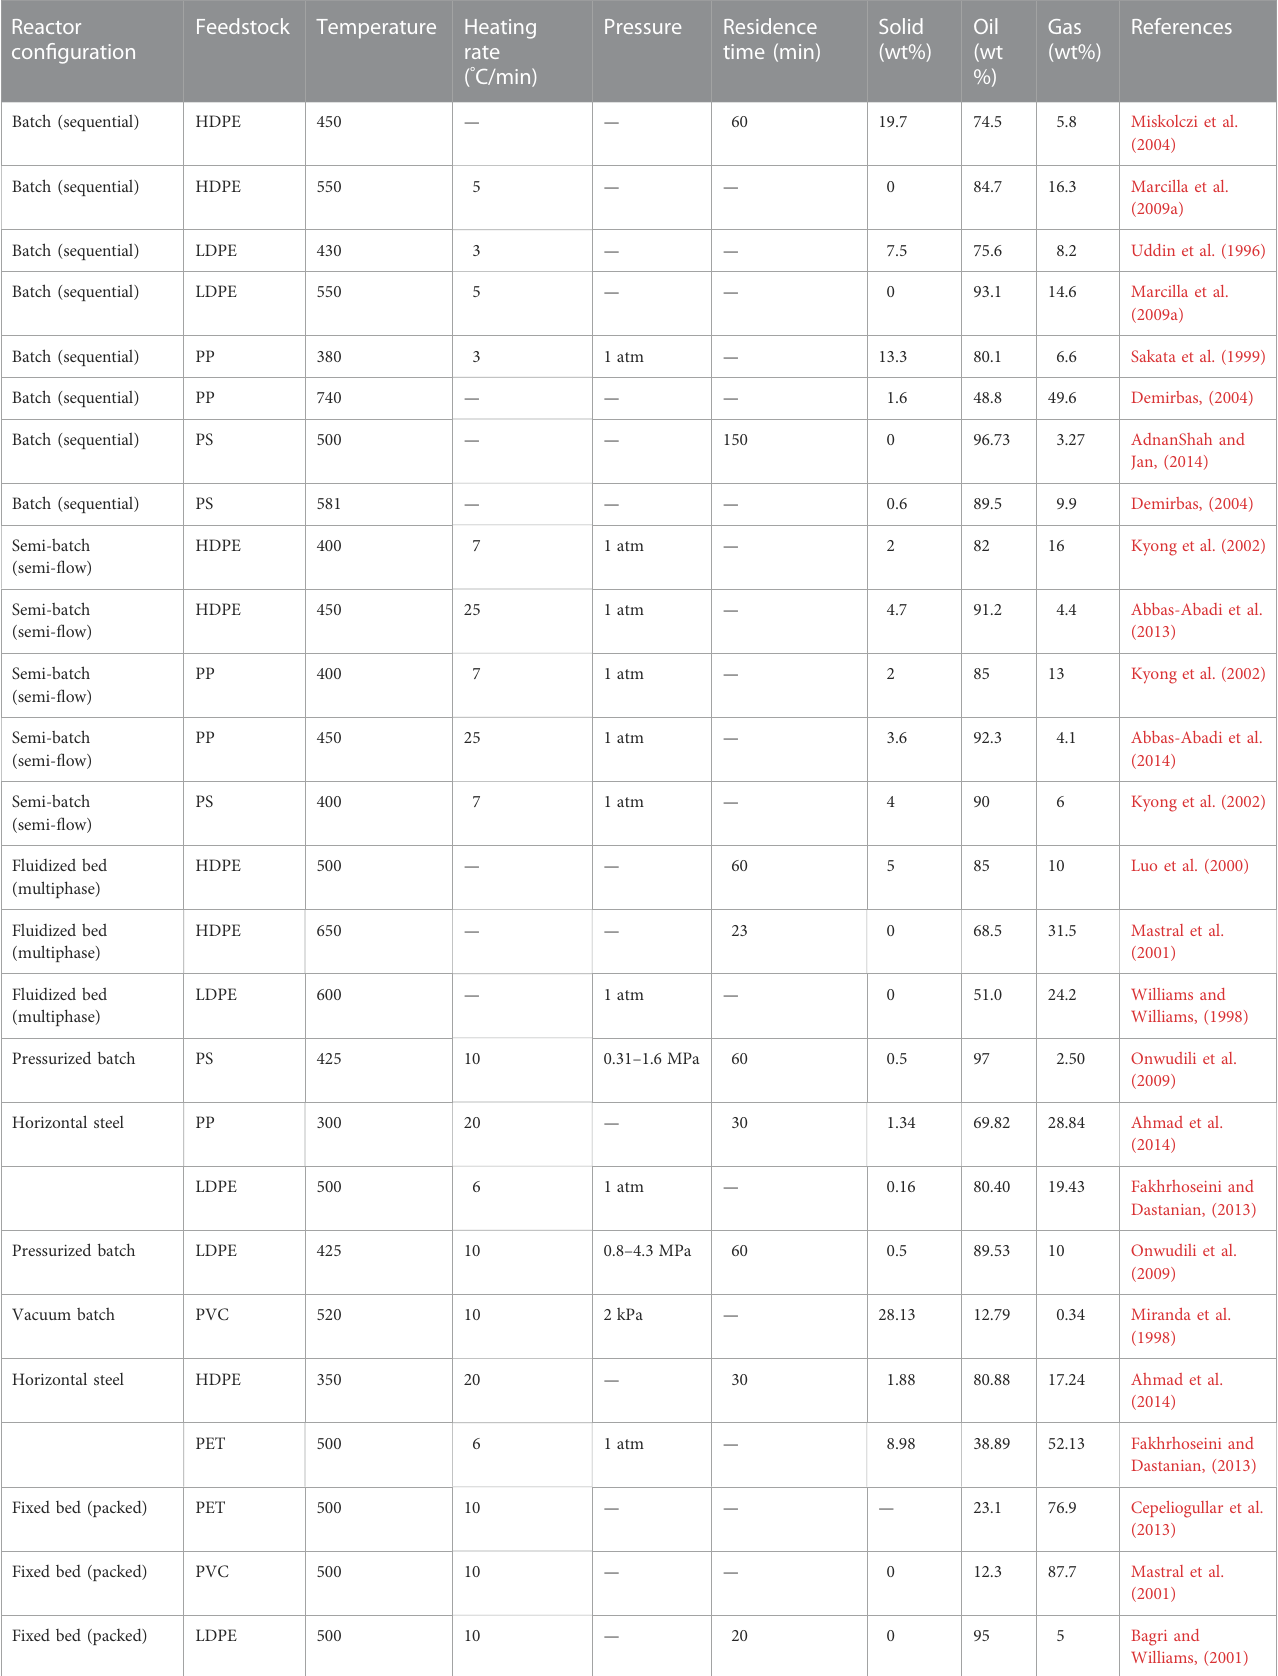
TABLE 11 Experimental results of pyrolysis of plastic waste by different